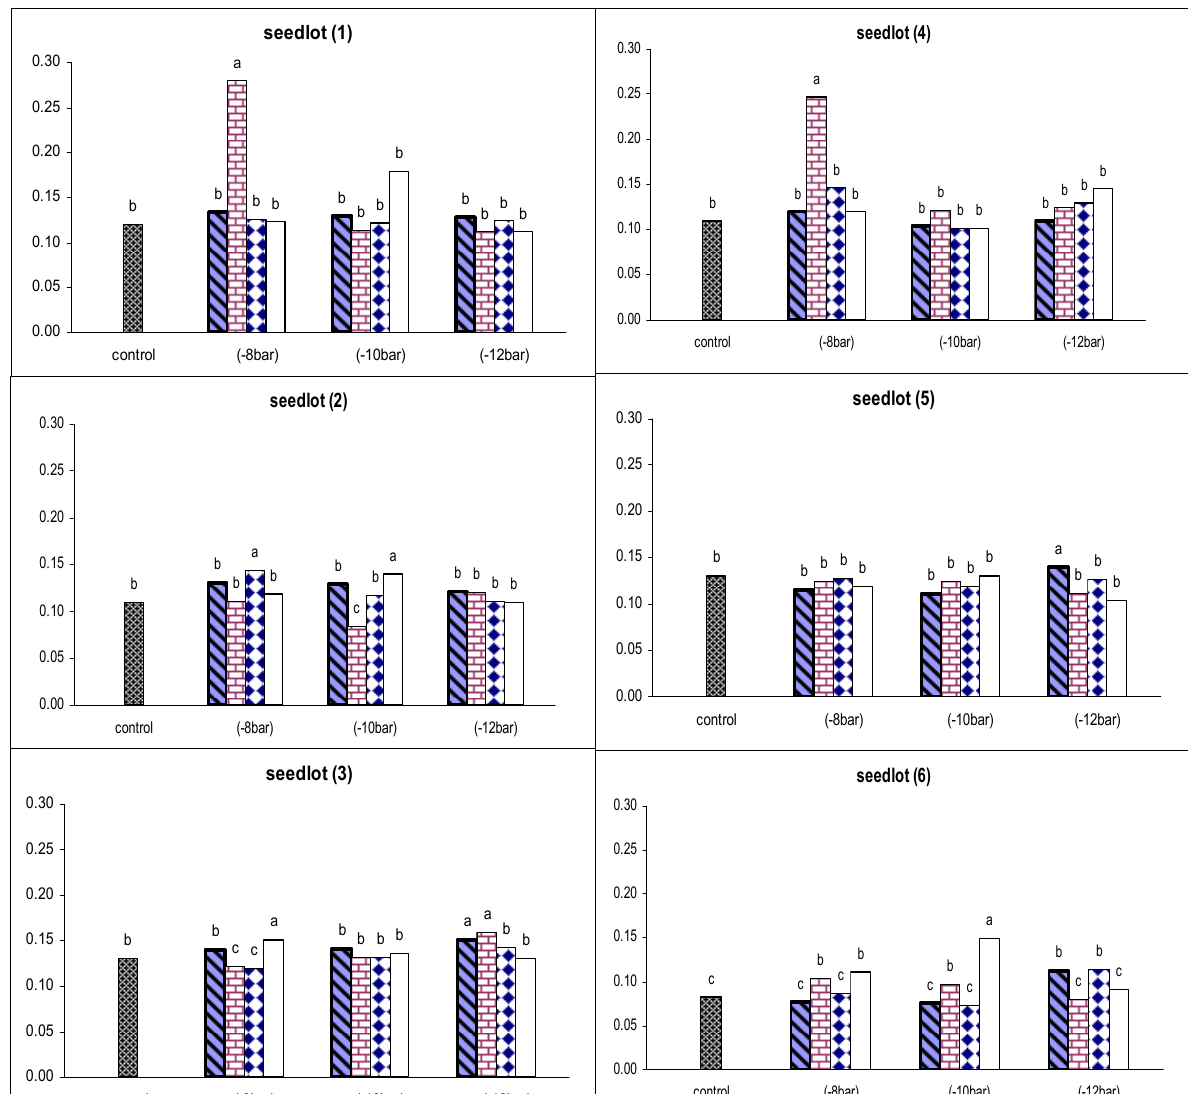
Fig. 3. Influence of osmotic potential levels of osmopriming treatments on the seedling dry weight (SDW) in soybean seed lots (cv. ‘Sari’) under 12 , 24 , 36 and 48 hours durations. Horizontal axe shows priming with -8 bar; -10 bar; -12 bar; polyethylene glycol and 0 bar as a control group . Vertical axe is seedling dry weight